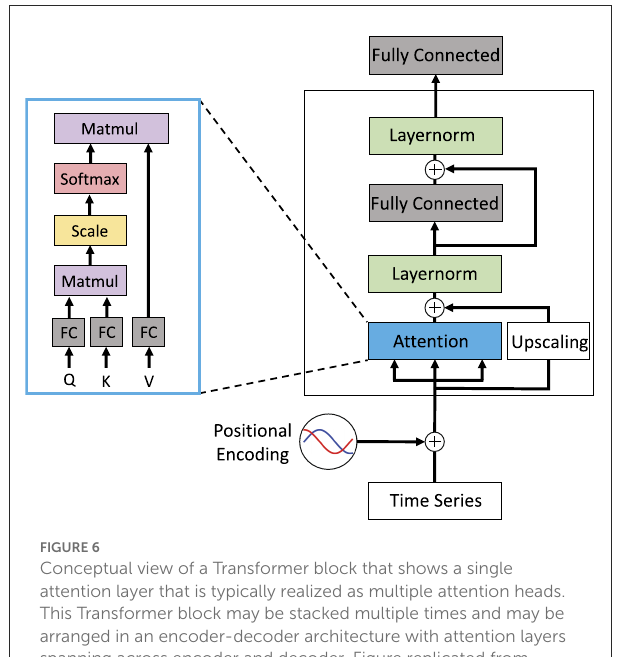
FIGURE7 Visualization of a single TCN block χ for time series classification. Each time step of the time series is taken as input (for better visibility some points are removed from the example). With a filter size λ = 2, two samples are convolved, respectively. In the following hidden layers, the dilation ∈ [1,2,4] with a maximum dilation δ = 4 skips several samples and increases the length of the receptive